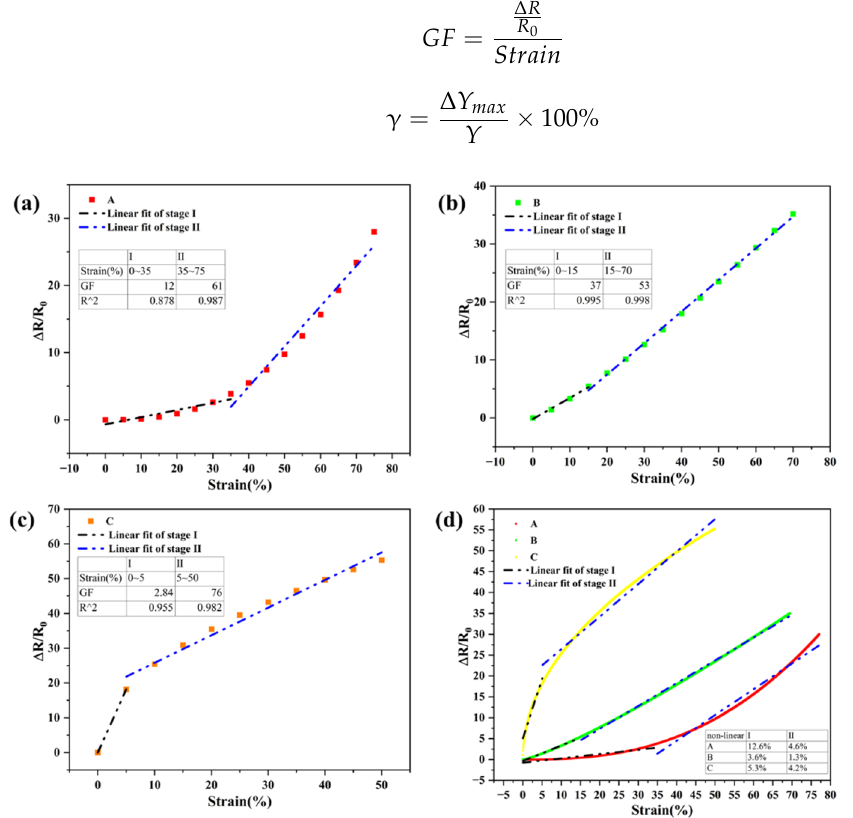
Figure 5. The GF and working range of Fe NW ‐ based flexible tensile strain sensor: ( a ) the GF of sample A changes with the increase in stretching, ( b ) the GF of sample B changes with the increase in stretching, ( c ) the GF of sample C changes with the increase in stretching, and ( d ) the nonlinear error of samples A, B, and C.